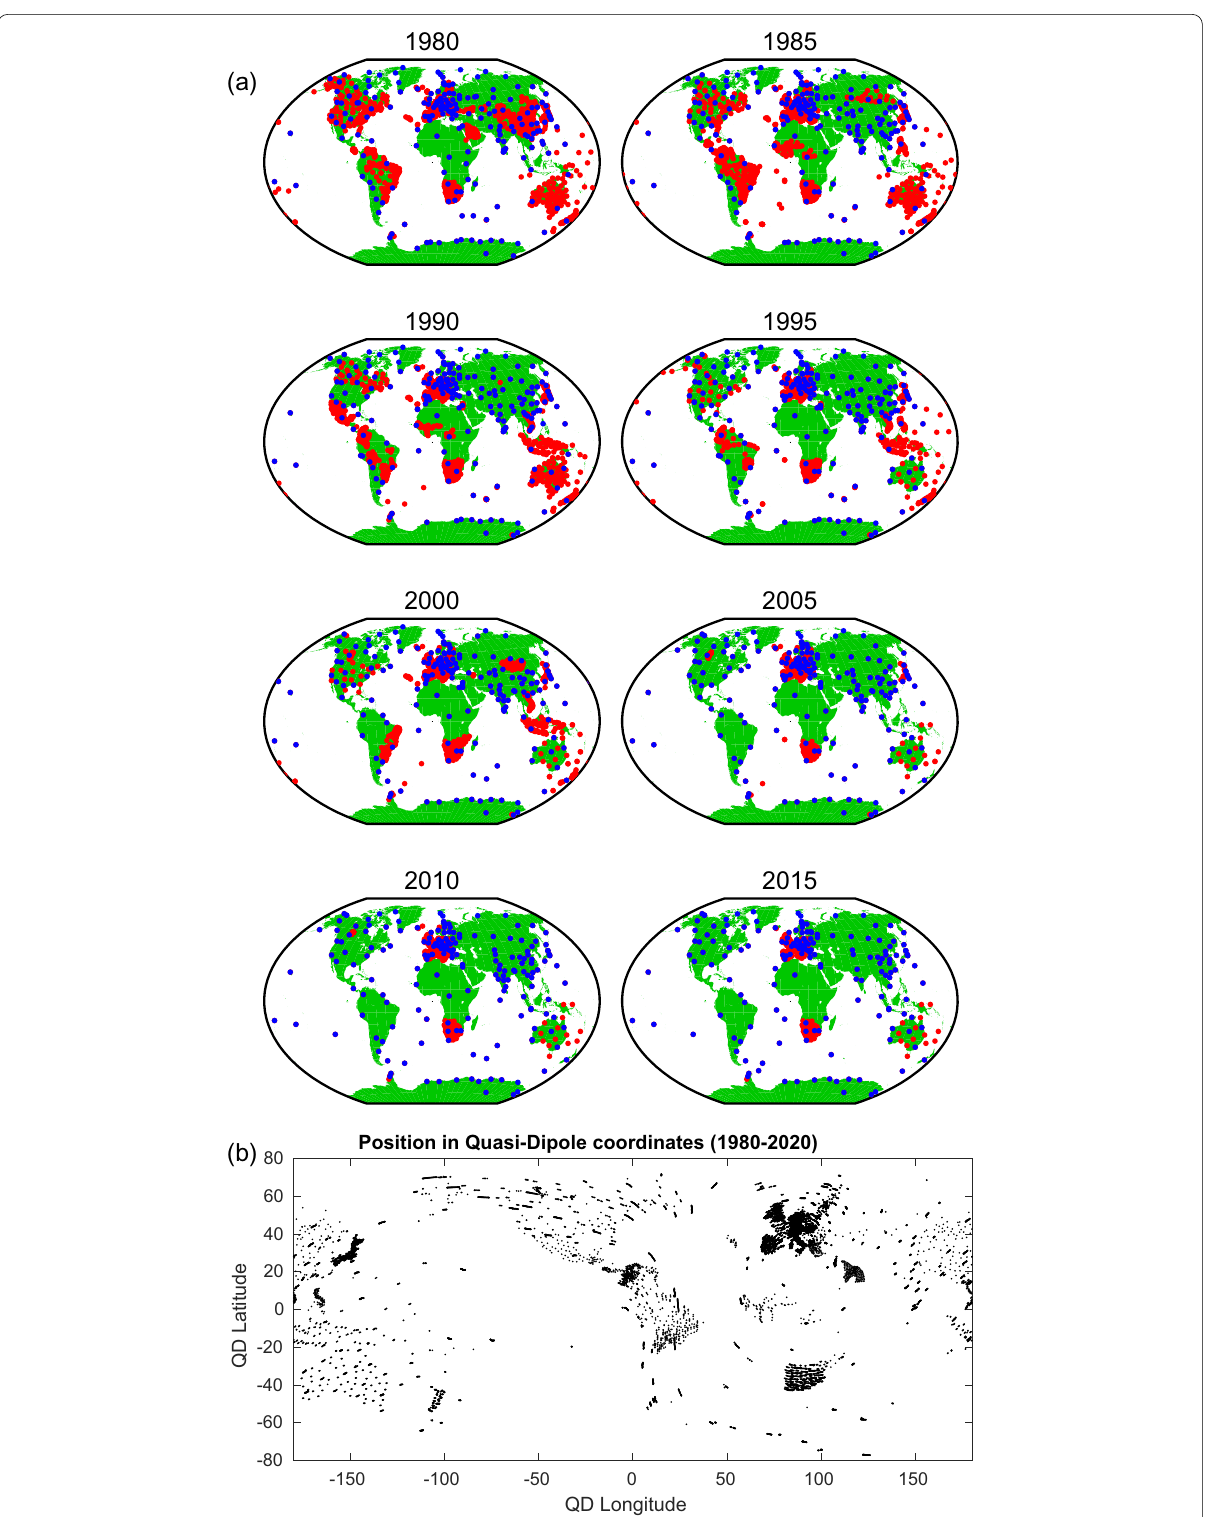
Fig. 1 Distributions of selected ground data in space and time. a Map of ground locations in each 5-year period from 1980 to 2020. Red circles are repeat stations; blue circles are observatories. b Map of the quasi-dipole locations over